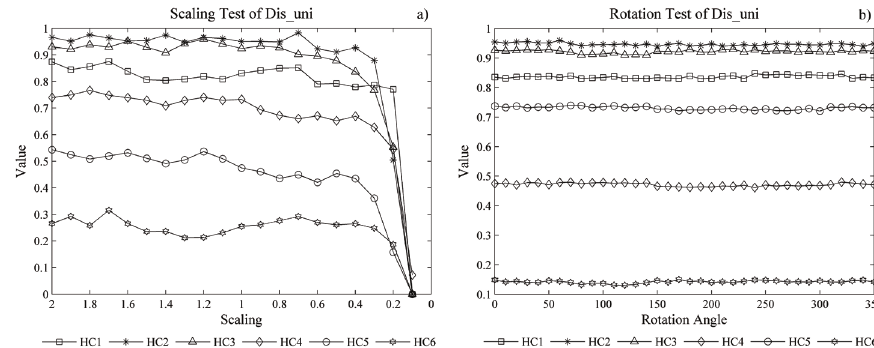
Figure 5. Tests of Dis_uni with Various Hydrophobic Levels. a) Scale Transformation, b) Rotation Transformation.